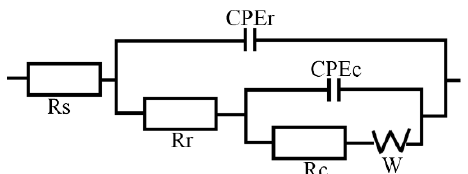
Figure 9. Equivalent impedance circuit for EIS data of three experimental steel groups.